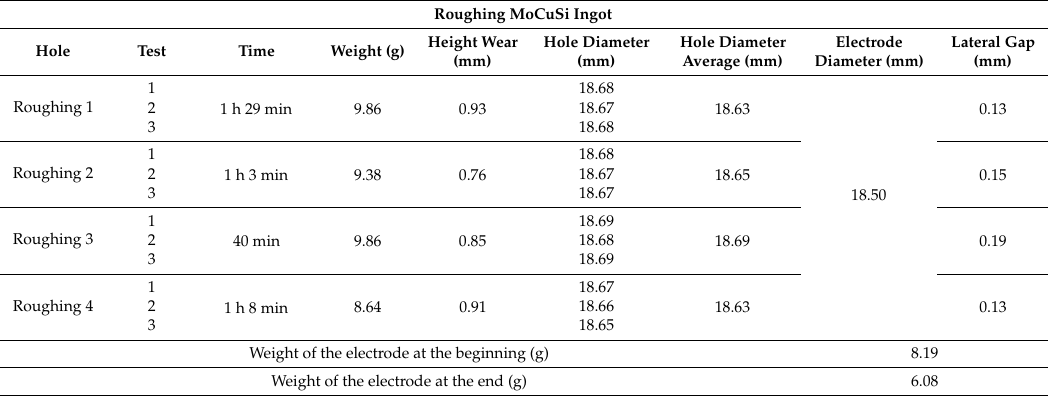
Table 8. Roughing results for the ingot MoCuSi.